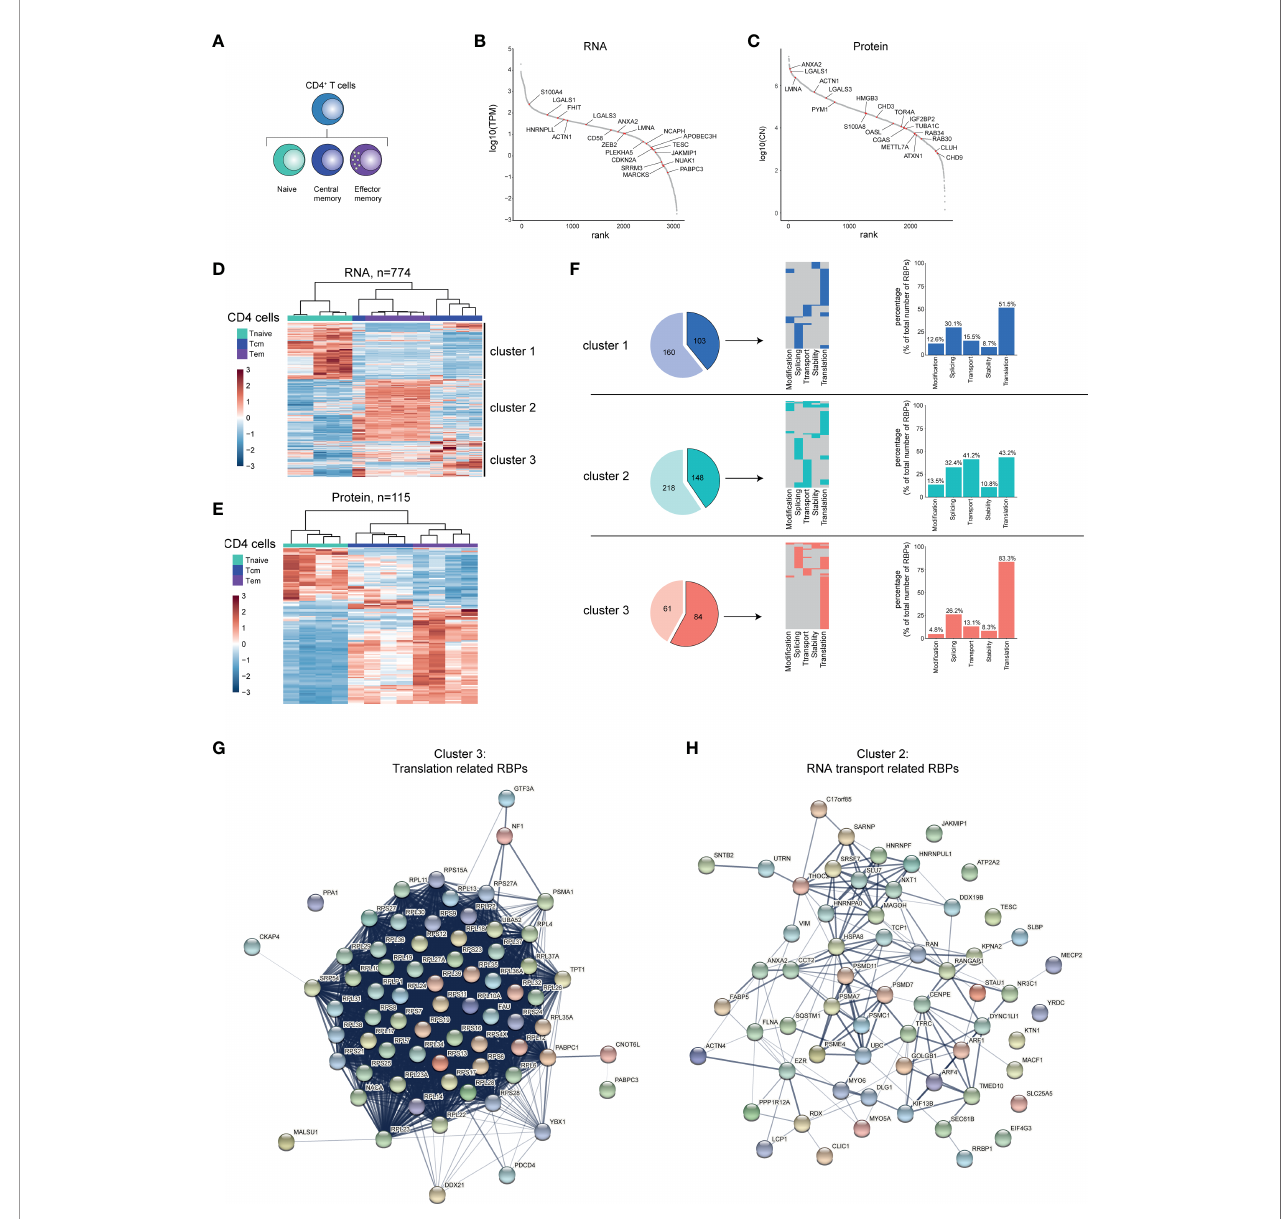
FIGURE 4 | RBP expression alters upon CD4 + T cell differentiation. (A) Diagram depicting the analysed CD4 + T cell subsets. (B, C) Expression levels of RBPs detected at RNA (B) or protein level (C) in human CD4 + T cells ranked according to expression levels. Red dots indicate top 20 most differentially expressed RBPs based on Log2 Fold Change. (D, E) Unsupervised clustering of DE RBPs at RNA (D) or at protein level (E) between naive (Tnaive), central memory (Tcm) and effector memory (Tem) CD4 + T cells depicted in a heatmap. RNA: n=5 donors, protein: n=4 donors. (F) Left panels: RBPs annotated for RNA splicing, stability, subcellular localization of RNA, RNA modi fi cation, and translation (dark colors) or for other processes (light colors) in the three clusters de fi ned in (D) . Middle panels: relative distribution between the 5 indicated RBP classes. Right panels: Percentage of RBPs annotated for indicated RNA-related biological processes. (G, H) String analysis on translation-related RBPs (G) identi fi ed in cluster 3 and on RNA transport-associated RBPs (H) identi fi ed in cluster 2. TPM, Transcripts per kilobase per million; CN, Protein copy